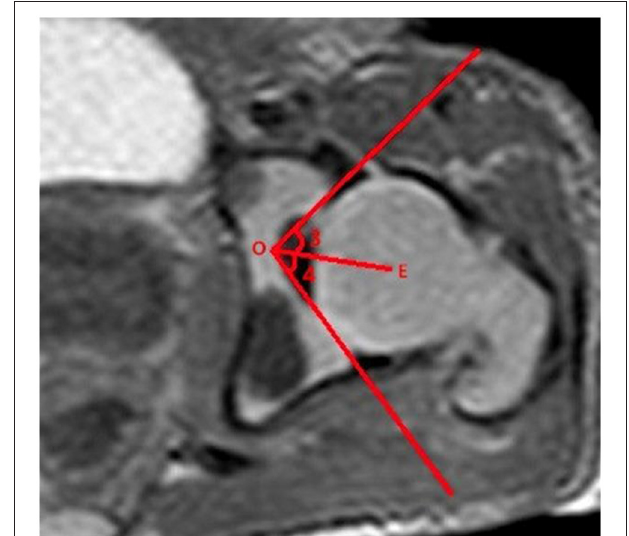
FIGURE 3 | Line OE is the baseline. Angle 3 is the ACAI and angle 4 is the PCAI.